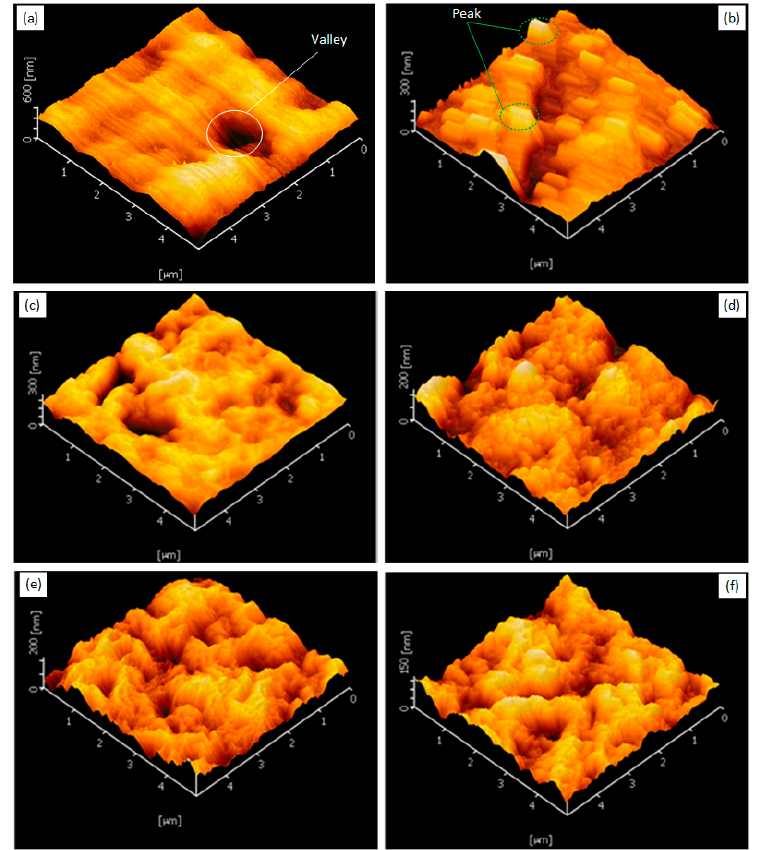
Figure 12. AFM Images ( a ) PVDF/DMF film, PDI composite film at ( b ) 25°C ( c ) 40°C ( d ) 50°C ( e ) 60°C ( f ) 70°C